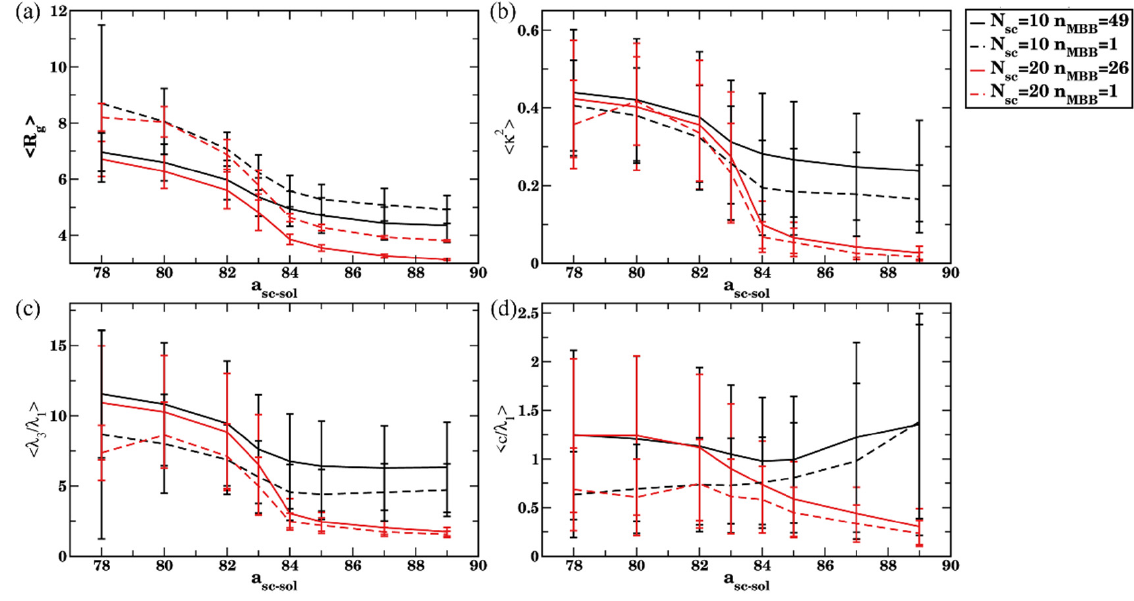
Figure 12. ( a ) Radius of gyration R g , ( b ) shape anisotropy κ 2 , ( c ) ratio of eigenvalues λ 3 / λ 1 , and ( d ) acylindricity normalized on the smallest eigenvalue, c/ λ 1 , of the bottlebrushes as a function of side chain affinities for multiple bottlebrushes (black curves) and single bottlebrushes (red curves). The solid and dash-dotted lines correspond to the sidechain length N sc = 10 and 20, correspondingly. For the multiple bottlebrushes (black curves), the data are averaged over all n MBB bottlebrushes within 60 frames (last 3 × 10 5 time steps) in four independent simulation runs, error bars represent standard deviations.